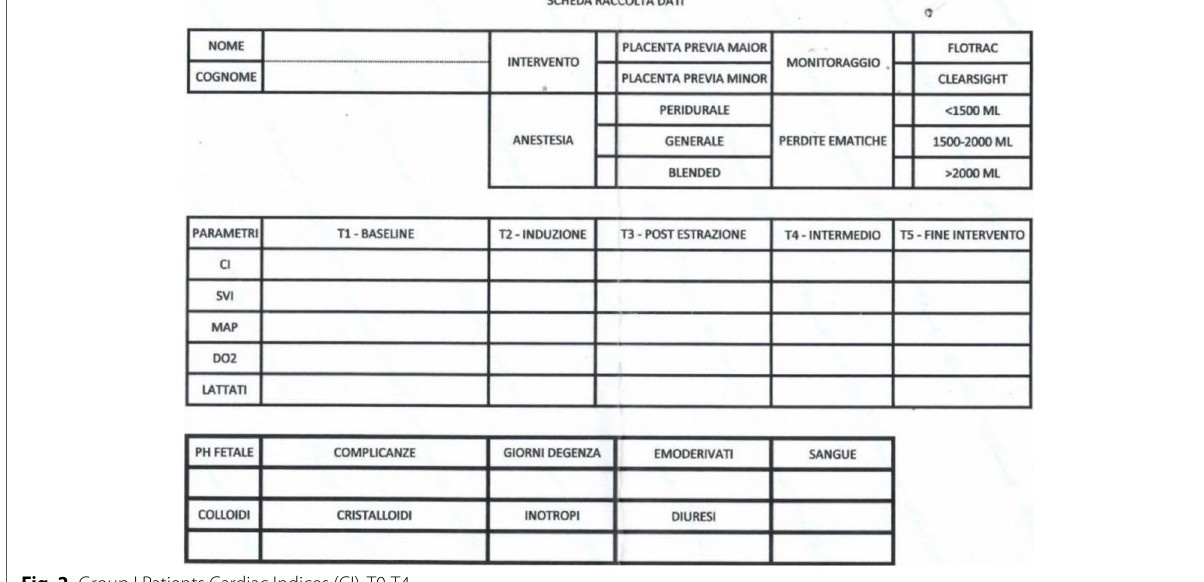
Fig. 2 Group I Patients Cardiac Indices (CI), T0-T4